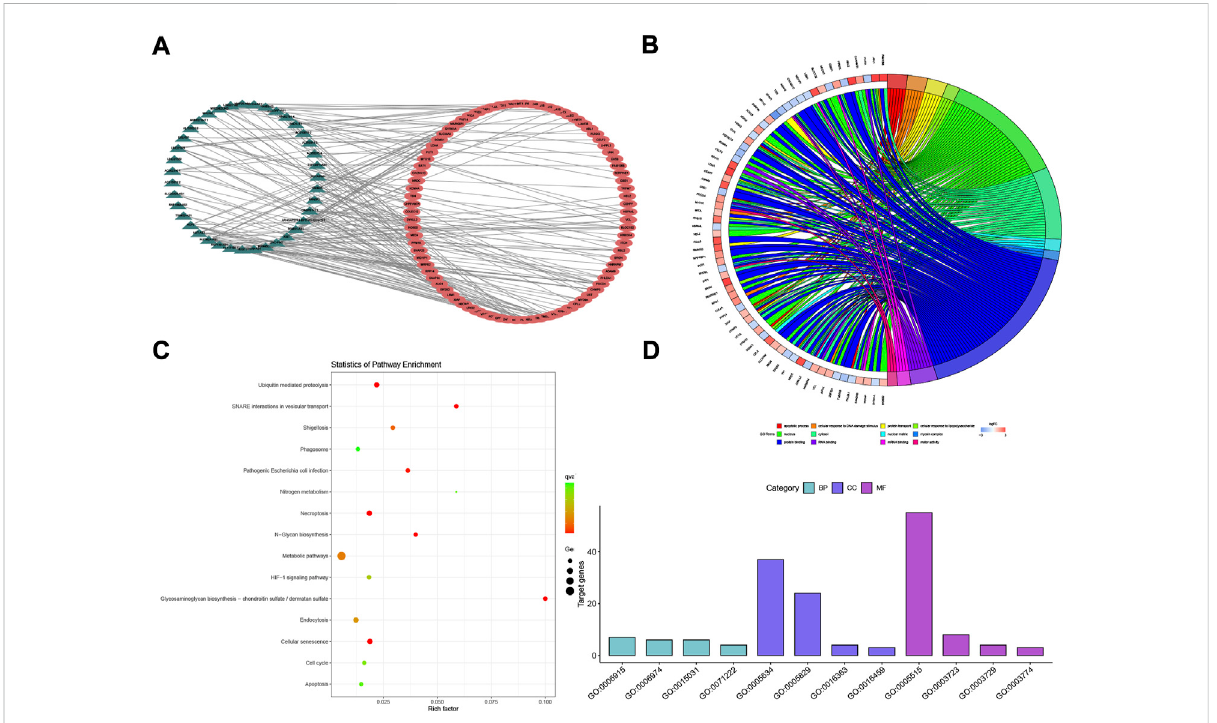
FIGURE 3 POI-based lncRNA – mRNA network (POILMN) and functional enrichment analysis of mRNAs. The dark green triangles represent lncRNA, and theredcycles represent mRNAs. Therewere39lncRNAnodes, 86mRNA nodes,and 177edgesinthenetwork (A) .Distribution of integrated DEGsin premature ovarian insuf fi ciency for different GO-enriched functions (B) . KEGG pathway enrichment analysis of the integrated DEGs (C) . The GO enrichment bar chart of DEGs presents the number of DEGs enriched in biological processes, cellular components, and molecular functions (D)